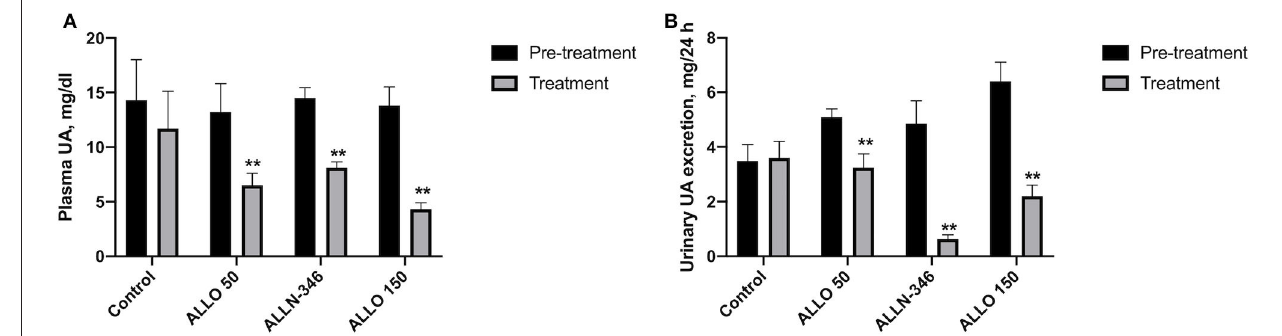
FIGURE 1 | Plasma UA level (A) and urinary UA excretion (B) in uricase/UrOx deficient mice following the 7-day study. Data are shown as mean ± SEM. Control group, no treatment ( n = 7); ALLO 50 group, allopurinol supplemented in drinking water (50 mg/L) ( n = 8); ALLO 150 group, allopurinol supplemented in drinking water (150 mg/L) ( n = 9); ALLN-346 group, ALLN-346 mixed with food provided ad libitum ( n = 7). **Statistically significant differences considering p < 0.05 for comparison between pretreatment and treatment periods.